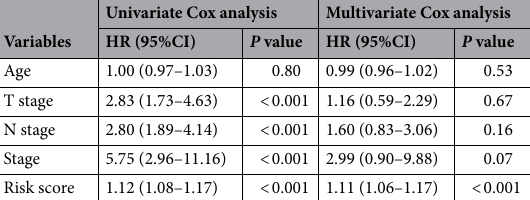
Table 1. The Cox regression analysis was performed to identify independent predictor of prognosis in TCGA- TNBC patients.